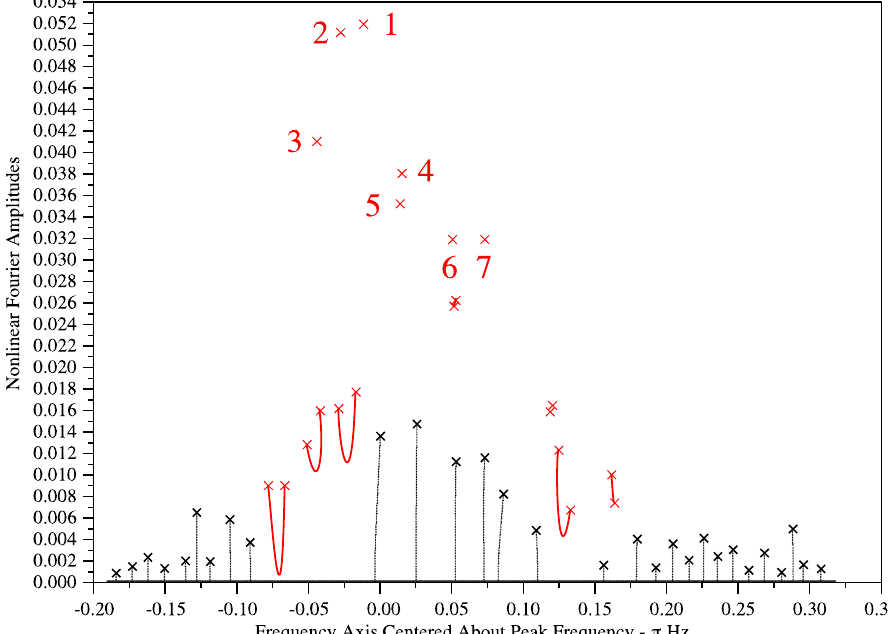
Figure 26. A 4096-point time series from probe 8 at 70 m from the wave maker in the experiments of Figure 25. Three extreme waves have amplitudes that are greater than three standard deviations. The largest packets (associated with their NLFA components, see Figure 20) are indicated by red numbers. The largest packet is greater than twice the significant wave height.